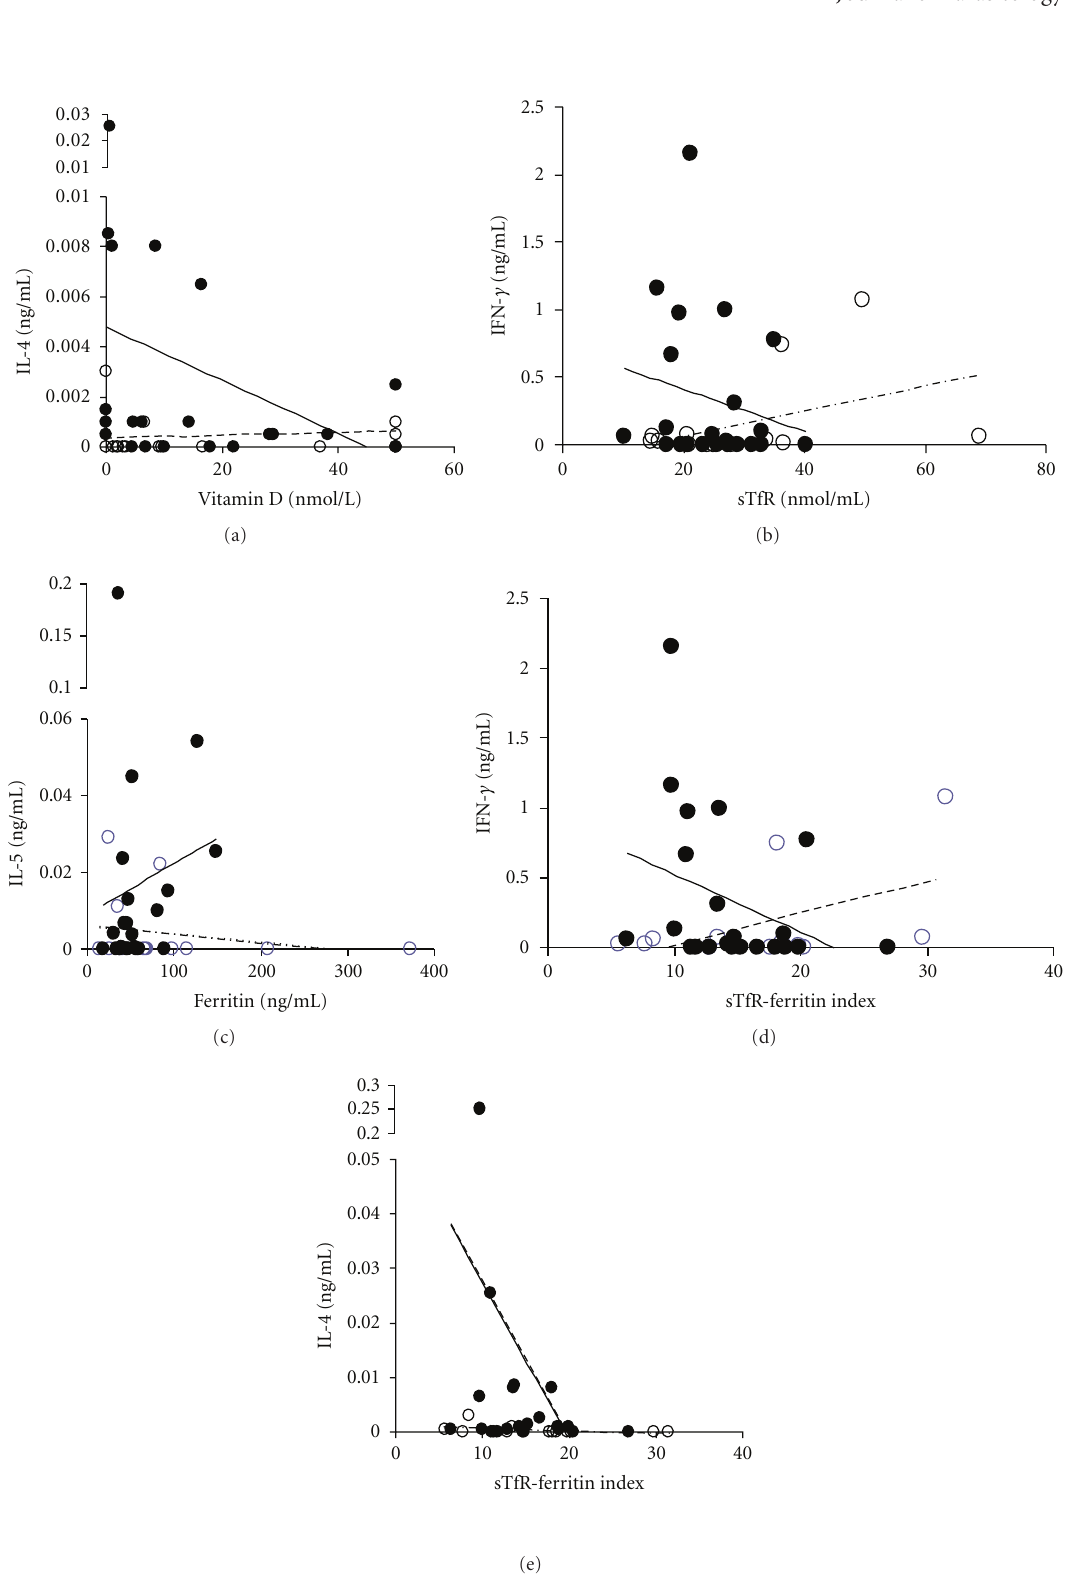
Figure 2: Relationship between micronutrients and cytokines showing associations significant that are significant from the ANOVA analyses (Table 2). Solid symbols and lines indicate egg positive people, open symbols and dashed lines represent egg negative people. (a) IL-4 level versus vitamin D, (b) IFN- γ versus soluble transferrin receptor (sTfR), (c) IL-5 versus ferritin levels (measure of stored iron levels), and (d) IFN- γ versus sTfR-F index (ratio soluble transferrin receptor/log Ferritin), a measure of stored and functional iron levels. (e) IL-4 versus sTfR-F index (ratio soluble transferrin receptor/log ferritin), a measure of stored and functional iron